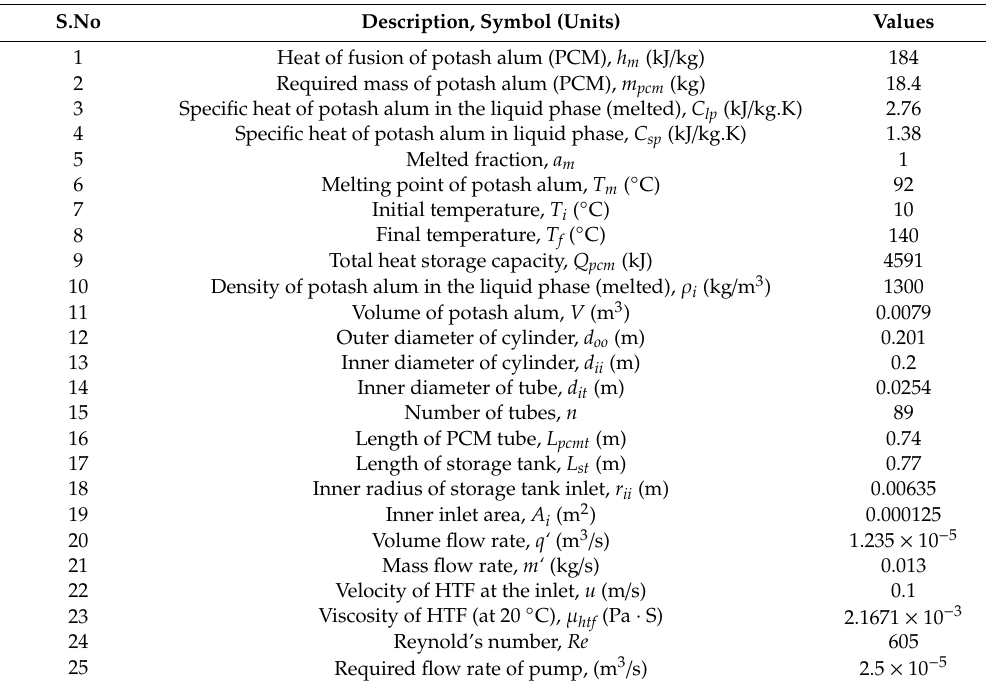
Table 3. Design parameters of the storage tank, PCM and